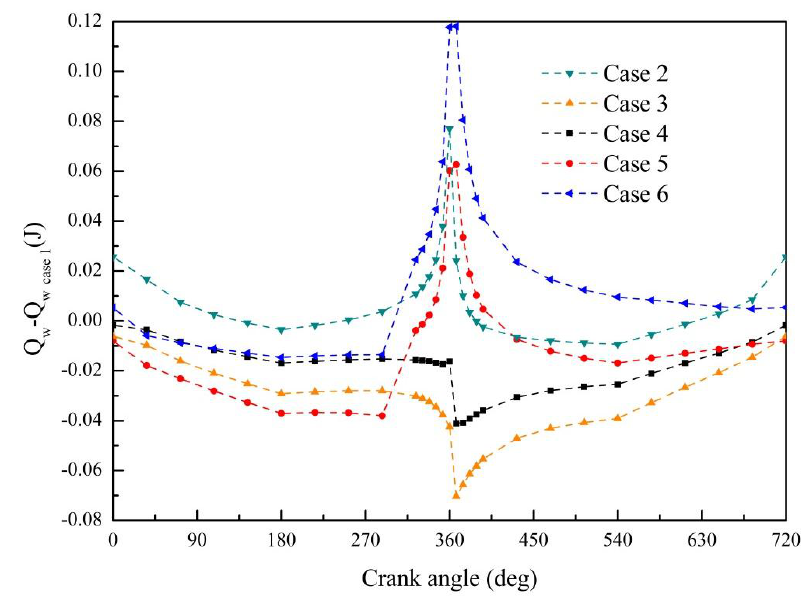
Figure 10. Difference of cylinder wall heat loss.